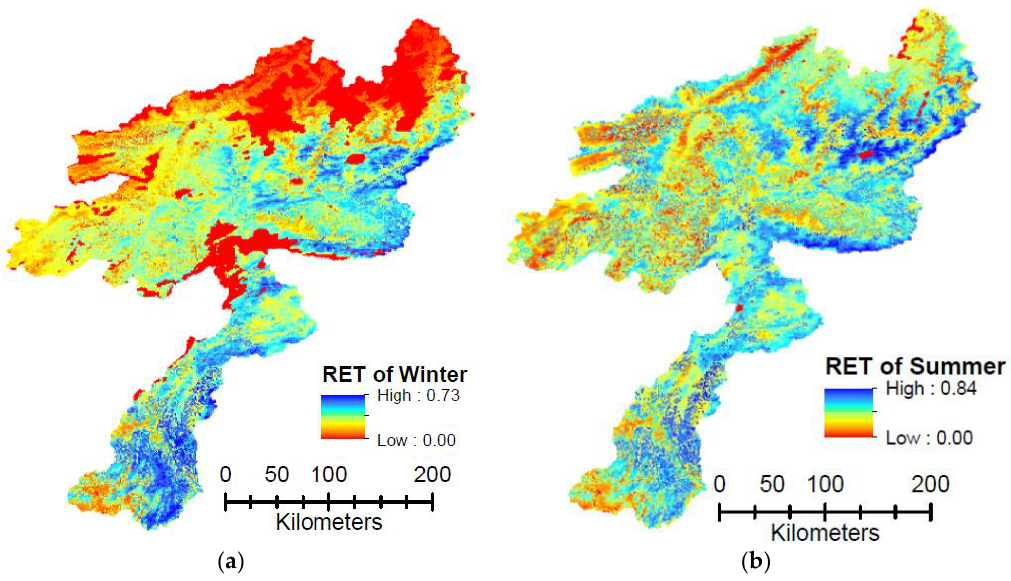
Figure 10. Seasonal relative evapotranspiration in ( a ) Winter and ( b ) Summer across the Kabul River Basin.